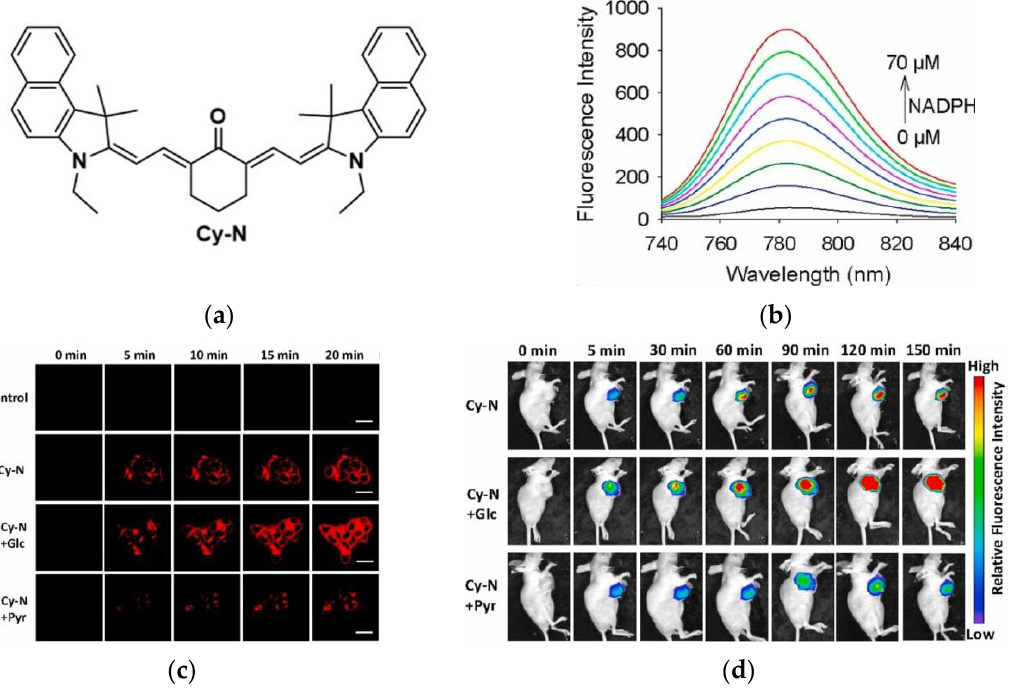
Figure 39. ( a ) Structure of probe Cy-N; ( b ) Fluorescence spectra of Cy-N; ( c ) Fluorescence imaging of NAD(P)H in HCT116 cells; ( d ) Fluorescence imaging of NAD(P)H in tumor-bearing mice. Reproduced with permission from [169]. Copyright 2021 Elsevier Ltd.